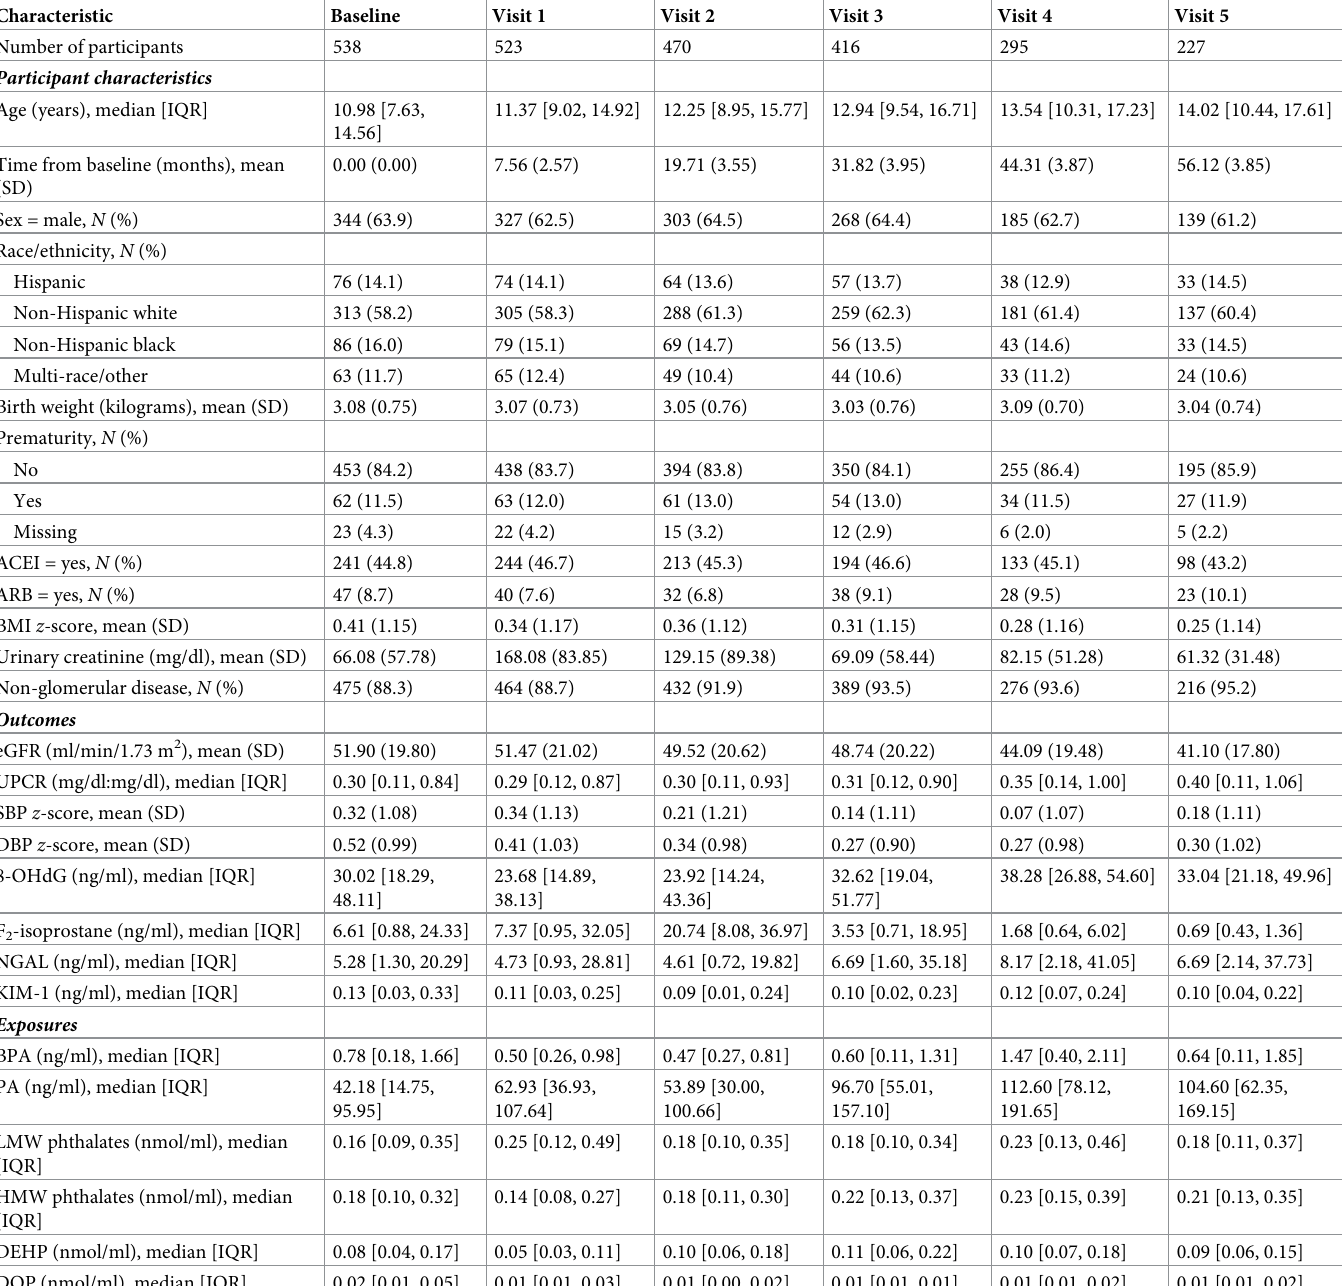
Table 1. Characteristics of study population by study visit: Chronic Kidney Disease in Children (CKiD) study, 2005–2015.